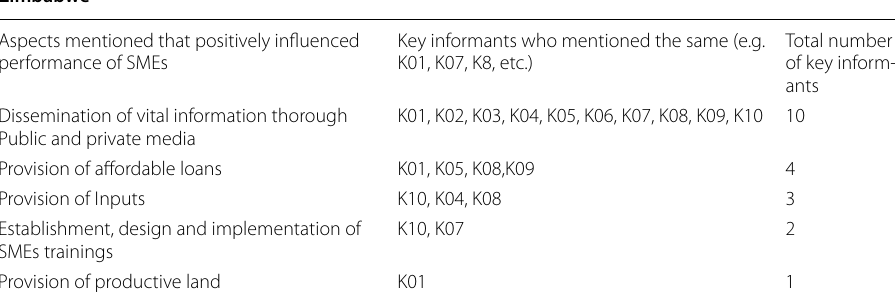
Table 4 Effects of government policies on SME performance (interviewees) Objective 1: government policy aspects that have positively influenced the performance of SMEs in Zimbabwe Aspects mentioned that positively influenced performance of SMEs